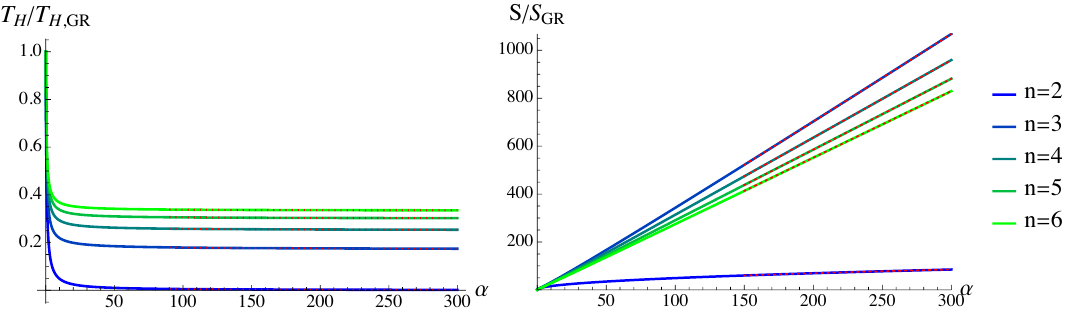
Figure 6 . Temperature and entropy vs. α . Numerical results are plotted by solid curves for each dimension. Red dotted curves are the fitting curves in eqs. (6.5) and (6.6) for n > 2 and eq. (6.7) for n = 2